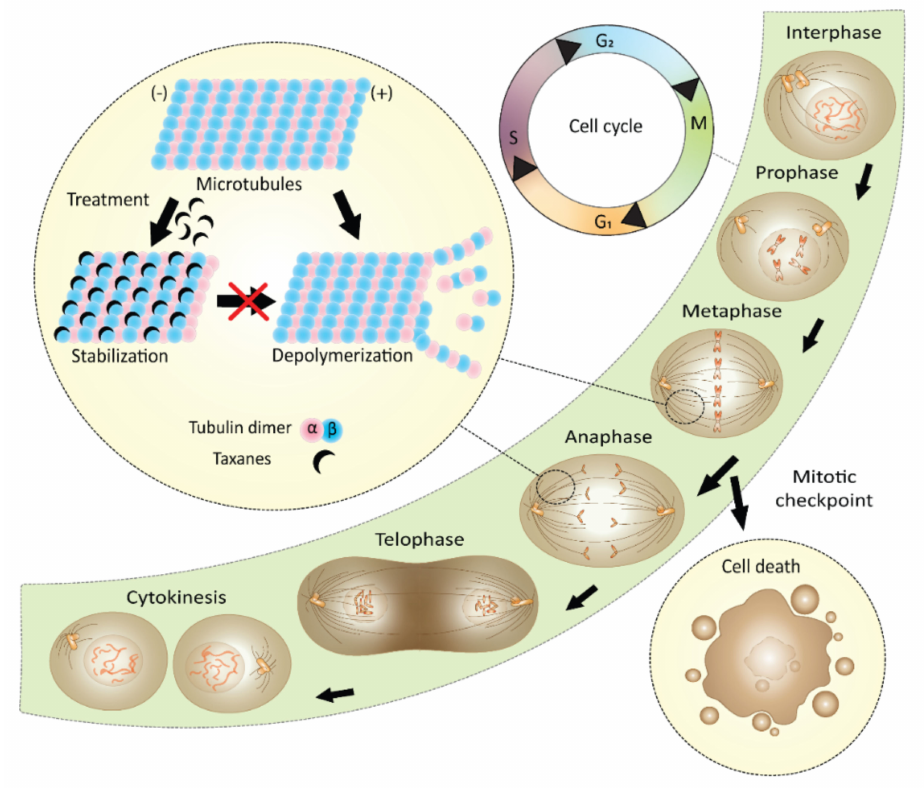
Figure 8. The mechanism of action of